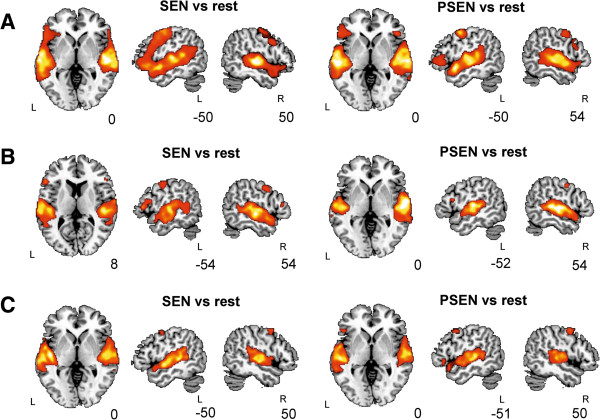
Whole brain fMRI activations for the three groups. Results are shown over an MNI template, at a p < 0.05 FDR-corrected threshold with 20 voxels of cluster extent using neurological convention. A. Healthy participants B. LMTLE patients. C. RMTLE patients. PSEN, Passive Listening to Pseudo Sentences; SEN, Passive Listening to Sentences; L, Left hemisphere; R, Right hemisphere.